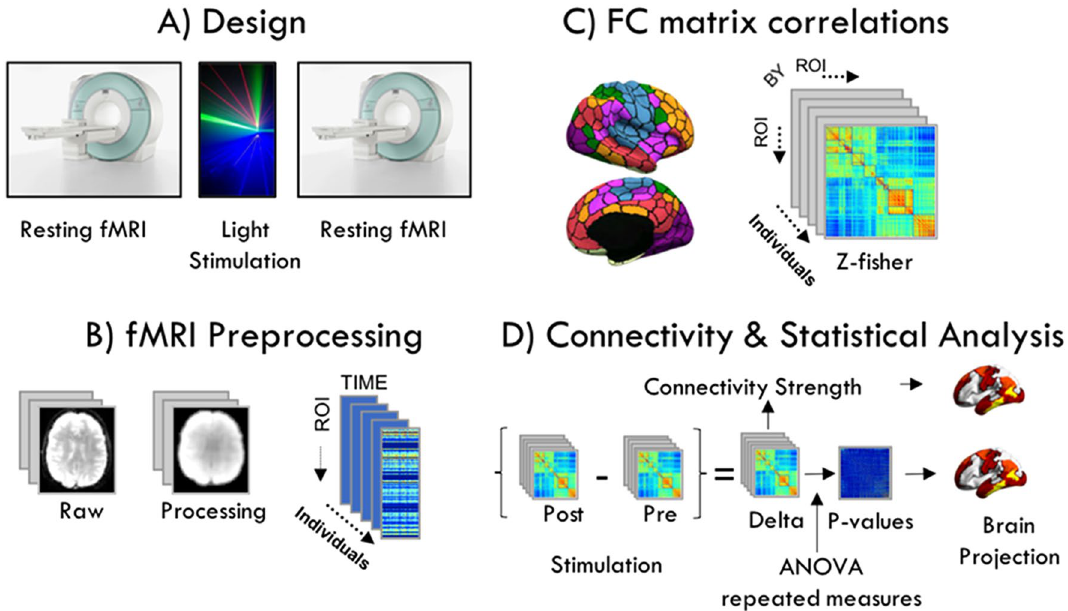
Figure 3. Workflow diagram. ( A ) The experimental design consisted of a repeated measures design where all the subjects underwent a resting fMRI session before and after receiving 1 min of light exposure to one of three wavelengths (green, blue, red) on three different days. ( B ) The fMRI analysis (see details in “Scanning protocol” section) yielded a time series for each individual. ( C ) The functional connectivity matrix for each subject was obtained after performing the Pearson correlation of the individual time series, and then we applied the Z-fisher transformation to perform the statistical analysis. The number of ROIs in the matrix correspond to the 100 ROI atlas used to extract the time series. ( D ) The connectivity analysis of the resting state networks was performed by computing the strength of connectivity within and between each network. To perform the statistical analysis, we first computed the difference between the FC post- and pre-stimulation yielding a delta matrix for each subject. These were used to perform the ANOVA repeated measures to find differences between the functional connections according to the kind of stimulation. This resulted in p value matrixes that were subsequently projected into the brain